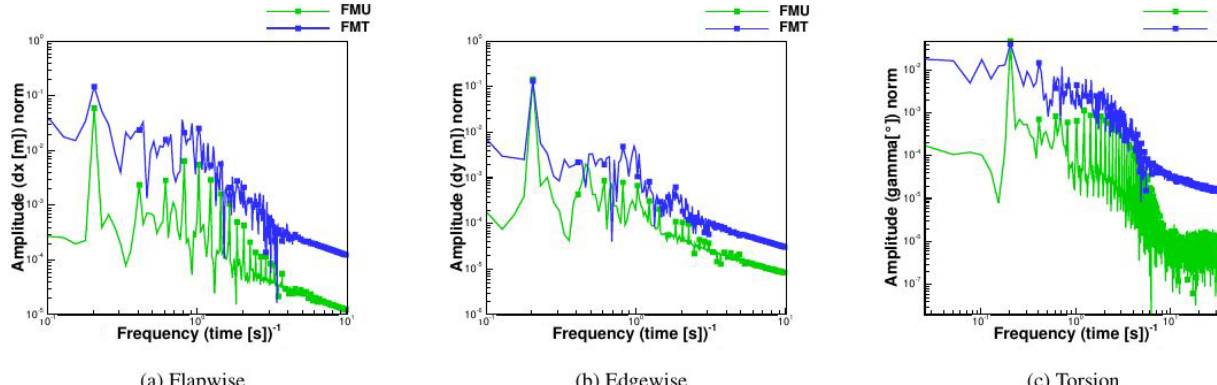
Figure 17. Spectra of the deformations comparing FMU vs. FMT.